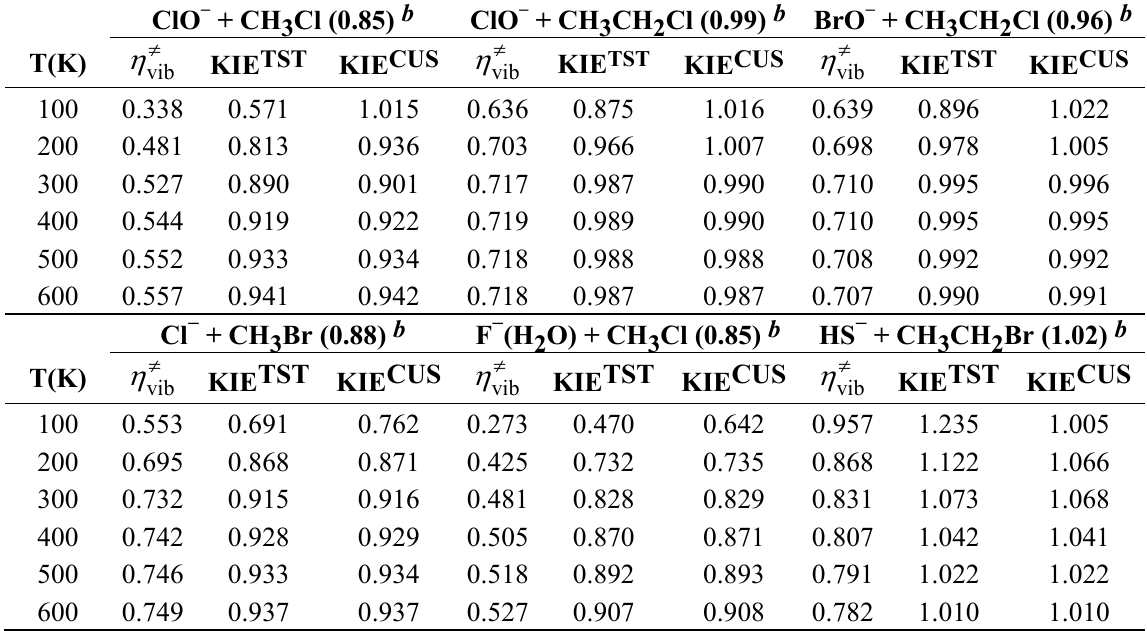
Table 6. Calculated deuterium KIEs and their vibrational contributions at different temperature a